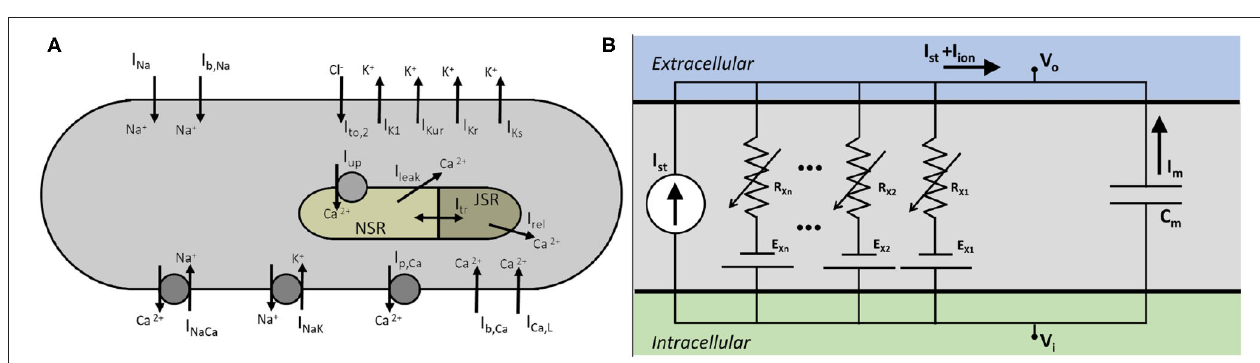
FIGURE 1 | (A) Schematics of a pig atrial cardiomyocyte model, showing transmembrane currents and the basic structure of the Ca 2 + dynamics. (B) Electrical circuit equivalent of the cell.